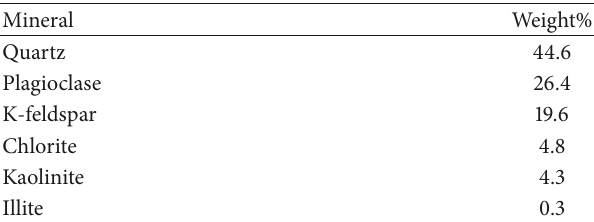
Table 1: Mineral composition of the sandstone sample using XRD analysis.